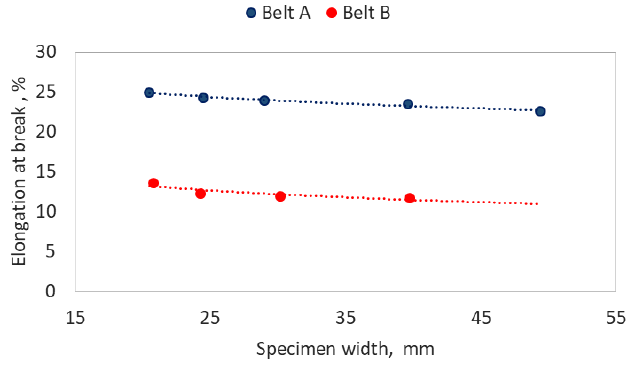
Figure 2. Influence of belt width on the results of belt elongation at break tests.